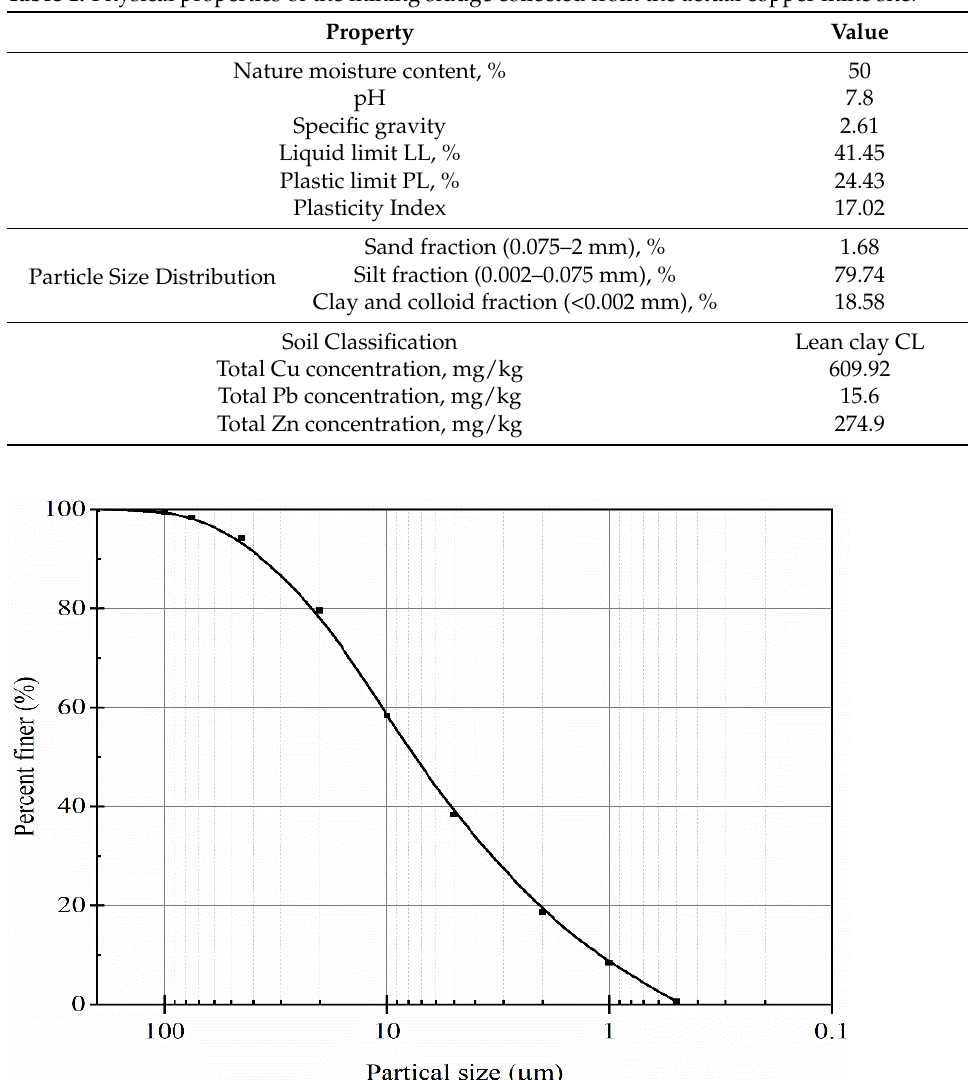
Figure 1. Particle size distribution of the sludge used in the laboratory experiments. Table 1. Physical properties of the mining sludge collected from the actual copper mine site.